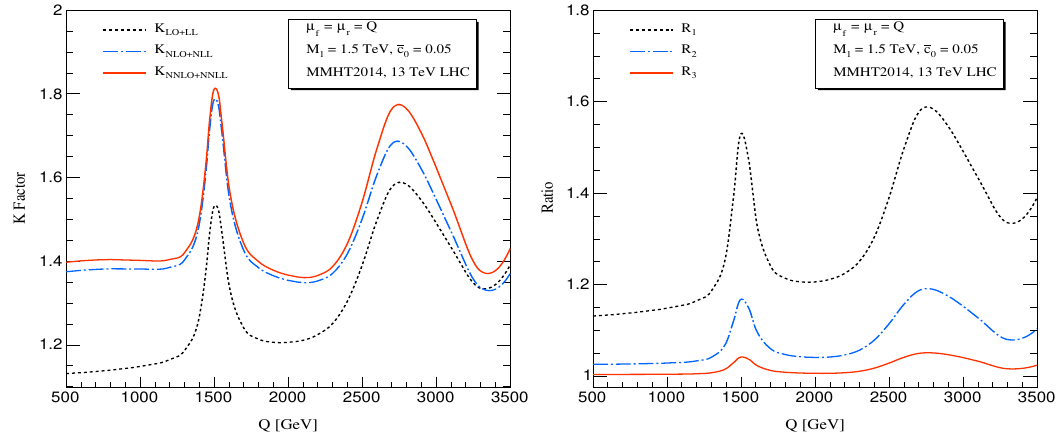
Figure 9 . Resummed K-factors for the di-lepton invariant mass distribution as de(cid:12)ned in eq. (3.3) and the corresponding ratios as de(cid:12)ned in eq. (3.4) (right).